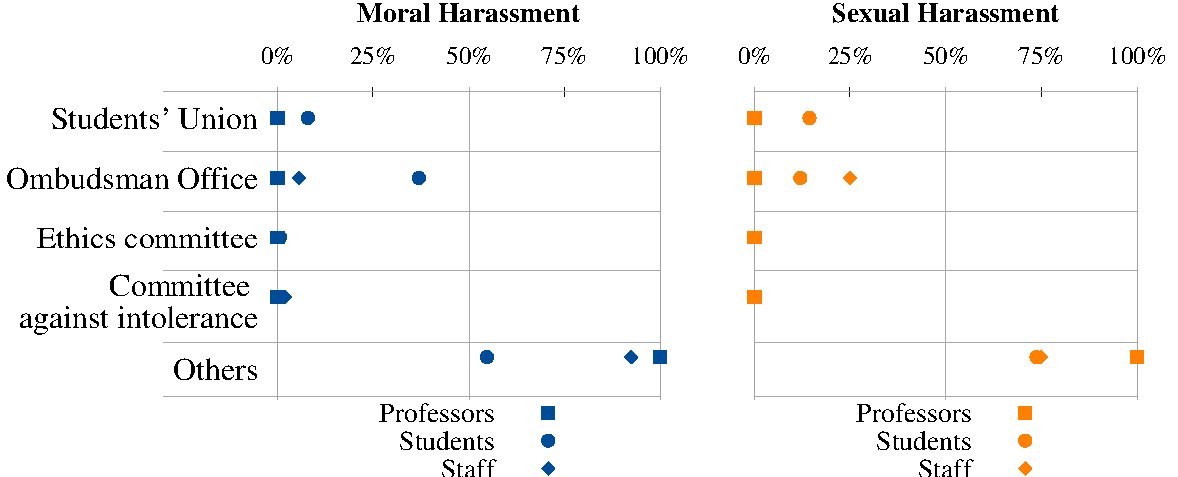
Figure 3. For respondents who reported moral harassment (left) and sexual harassment (right) there were four options to identify which were the reporting channels used to denounce the harassment. Professors, students, and technical administrative staff are discerned using different symbols as defined in the legend.